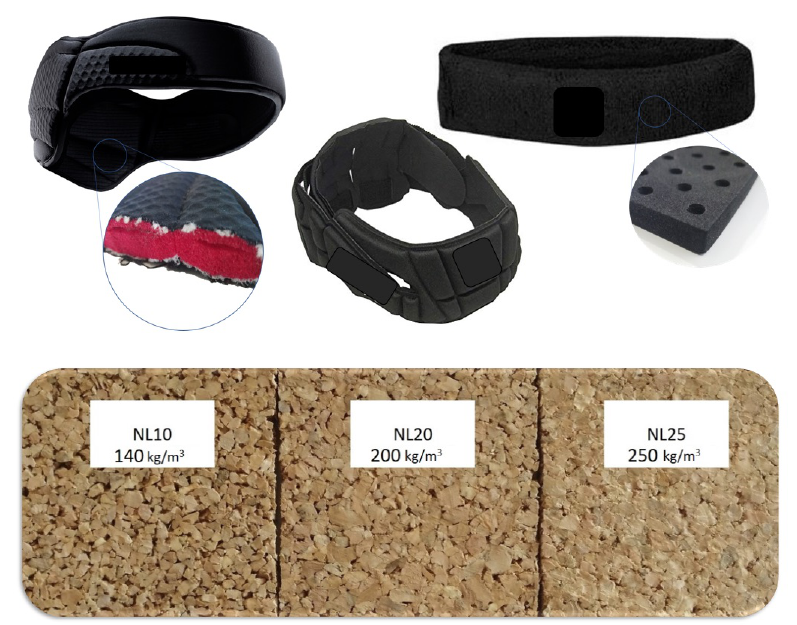
Figure 1. Commercial headbands and cork